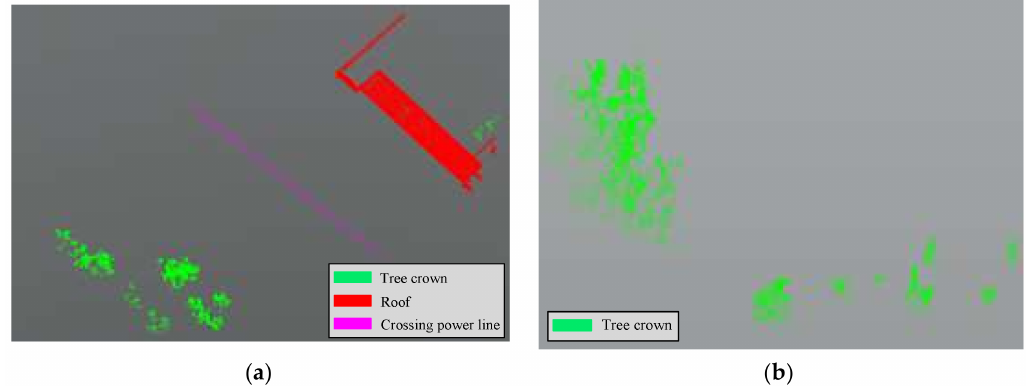
Figure 15. Recognized objects of the first dataset ( a ), the third dataset ( b ) in SFD partition.